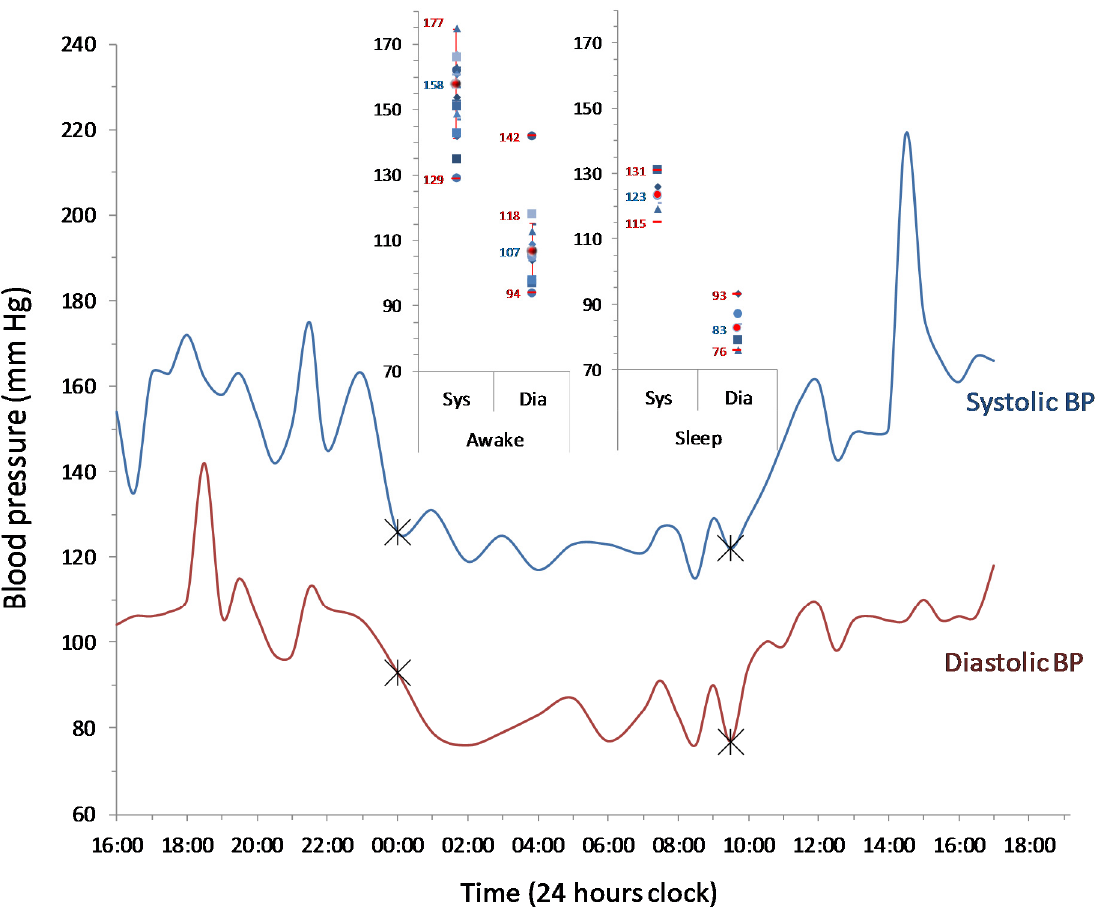
Figure 1. Twenty-four hour ambulatory blood pressure measurement in the subject. The lines represents systolic/diastolic blood pressure recorded over a 24 h period, where the measurements during sleep shows a nighttime dipping (indicated by crossed-marks). The inset shows a distribution of measurements (filled symbols) with minimum/maximum (red bars) and average readings (red filled-circles) in the same subject during sleep/awake cycles, where “Sys” and “Dia” refer to systolic and diastolic blood pressures, respectively.